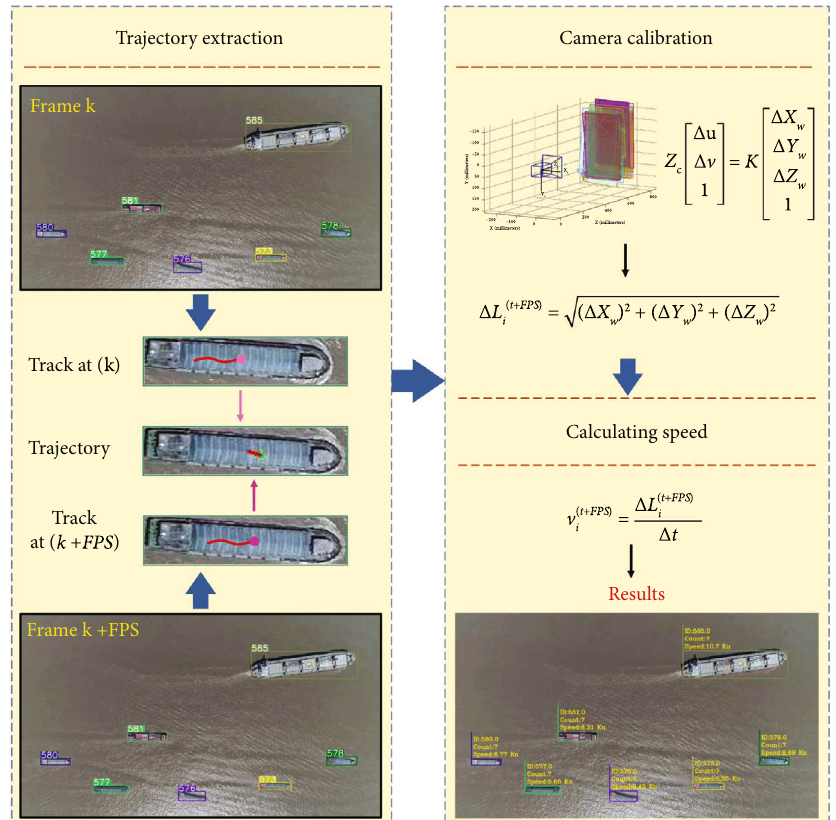
Figure 7: Elementary diagram of the speed measurement.